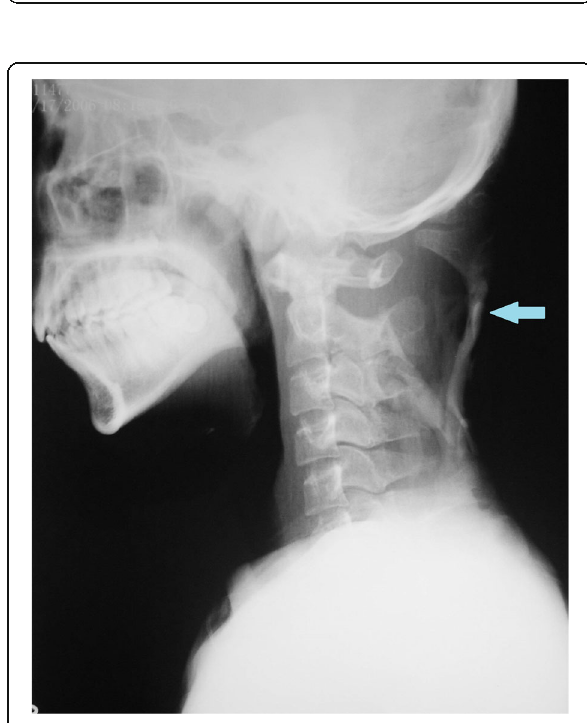
Fig. 2 CT scan showing several initial heterotopic ossification lesions in the pectoralis major and serratus anterior (arrows)